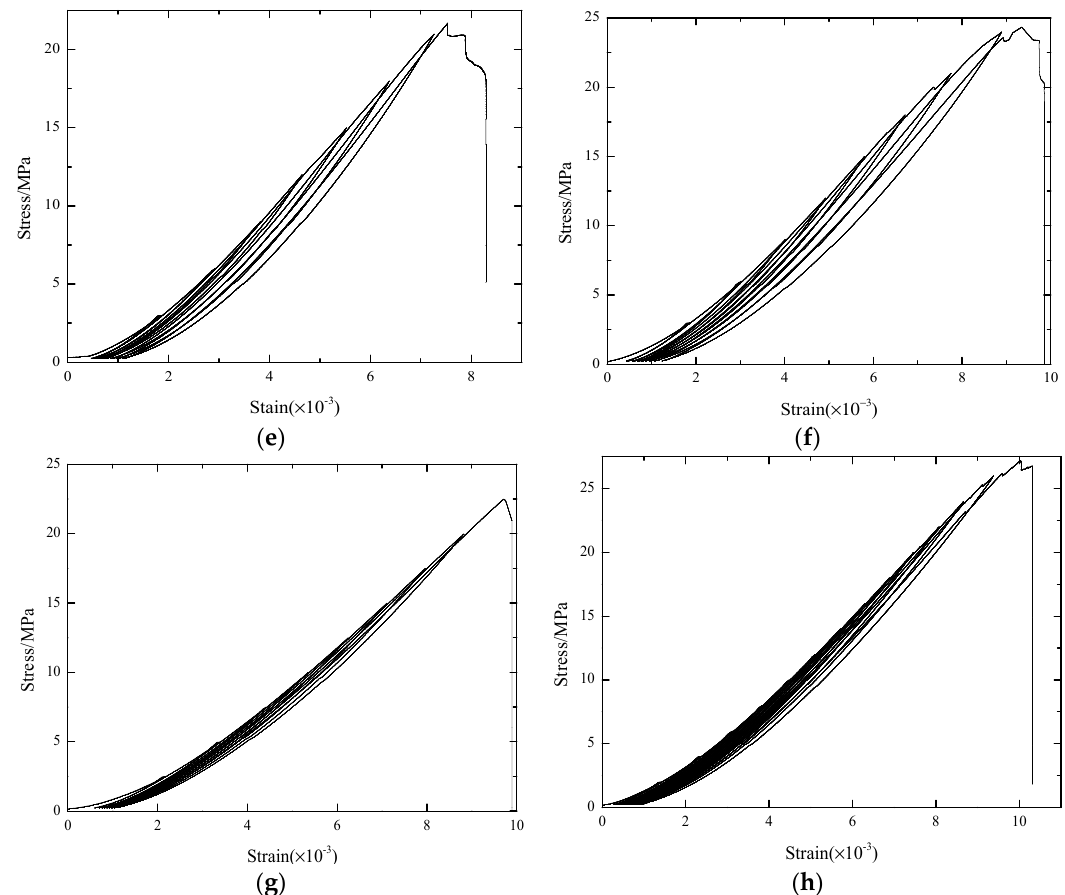
Figure 11. The complete stress–strain curve of the CRC specimens under uniaxial cyclic loading and unloading compression: ( a ) NYM 1 -3; ( b ) NYM 2 -6; ( c ) XSM 1 -5; ( d ) XSM 2 -6; ( e ) ZSM 1 -4; ( f ) ZSM 2 -6; ( g ) FSM 1 -3; ( h ) FSM 2 -7.